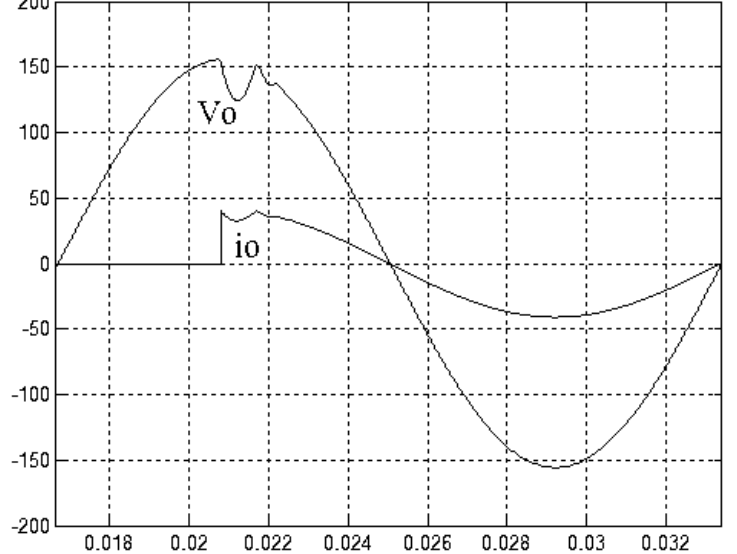
Figure 4. Simulated output waveforms at step-load changing conditions obtained using the conventional sliding mode control (SMC).